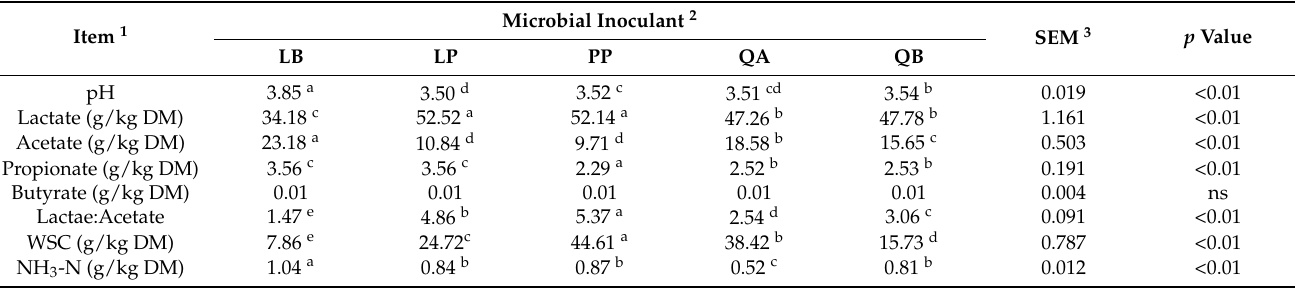
Table 2. Ensiling characteristics of whole corn silage after 60 days ensiling in response to different microbial